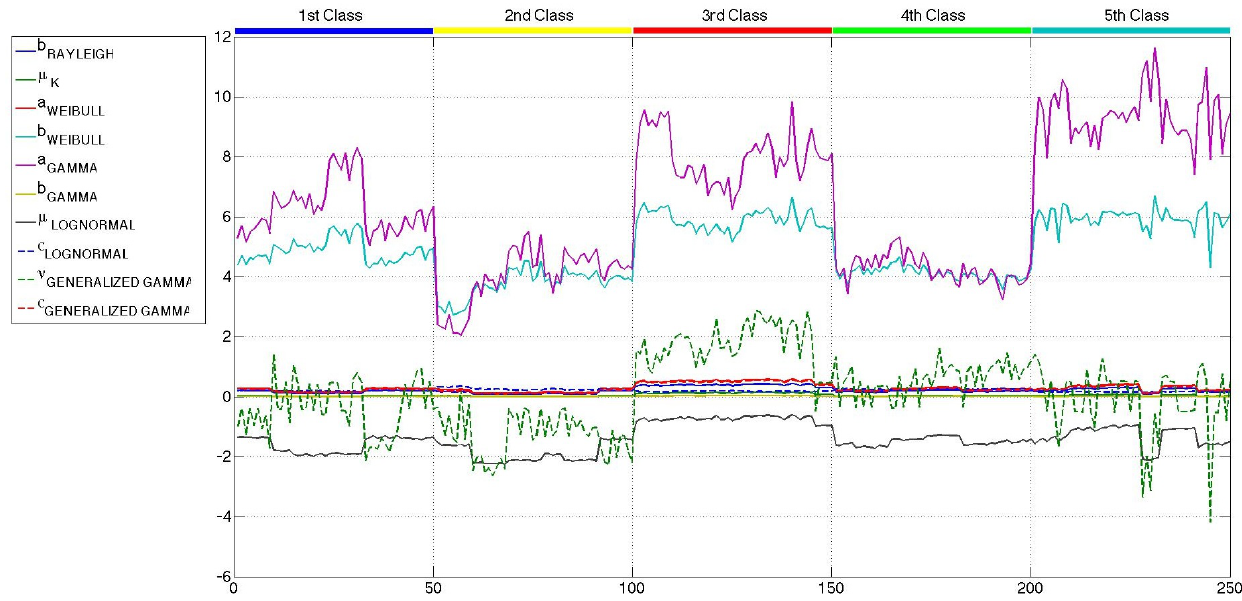
Figure 12. Selection of statistical parameters estimated from a reduced set of sigma-filtered patches. Fifty patches of each considered class are used for the